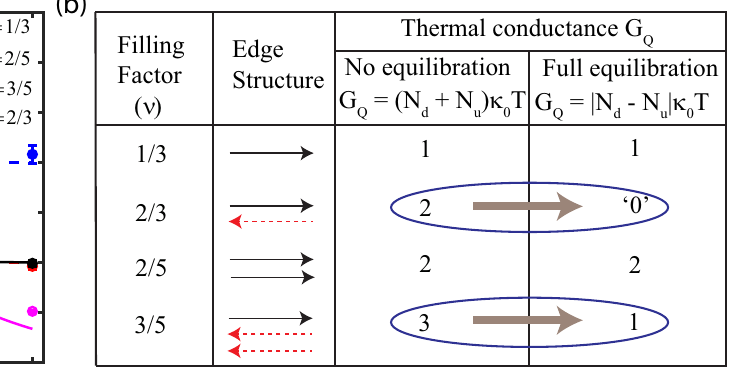
the standard deviation associated with the slope of the linear fi t shown in Fig. 3. b Edge structures of the studied FQH states. Solid black and dashed red arrows represent downstream and upstream modes, respectively. The two right-most columns show expected values of the thermal conductance G Q (in units of κ 0 T ) in the two limiting regimes of the heat